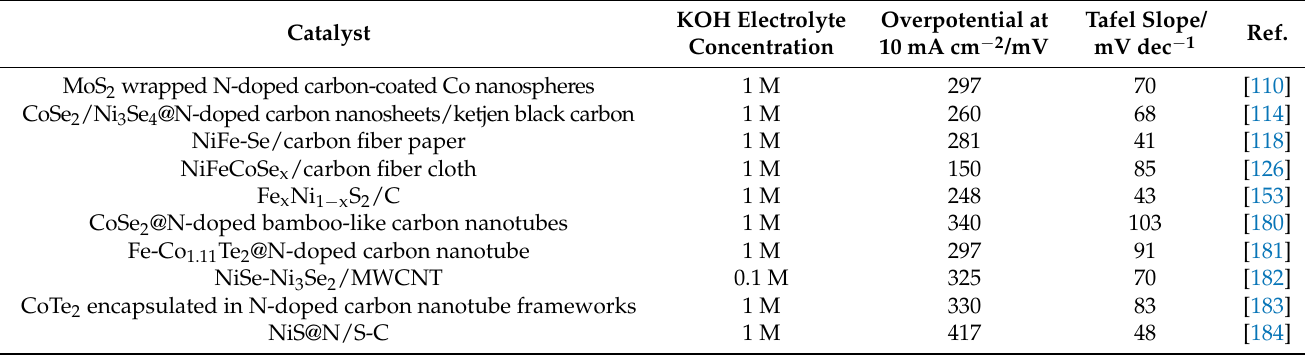
Table 4. Selection-comparison of carbon–metal chalcogenide electrocatalysts.